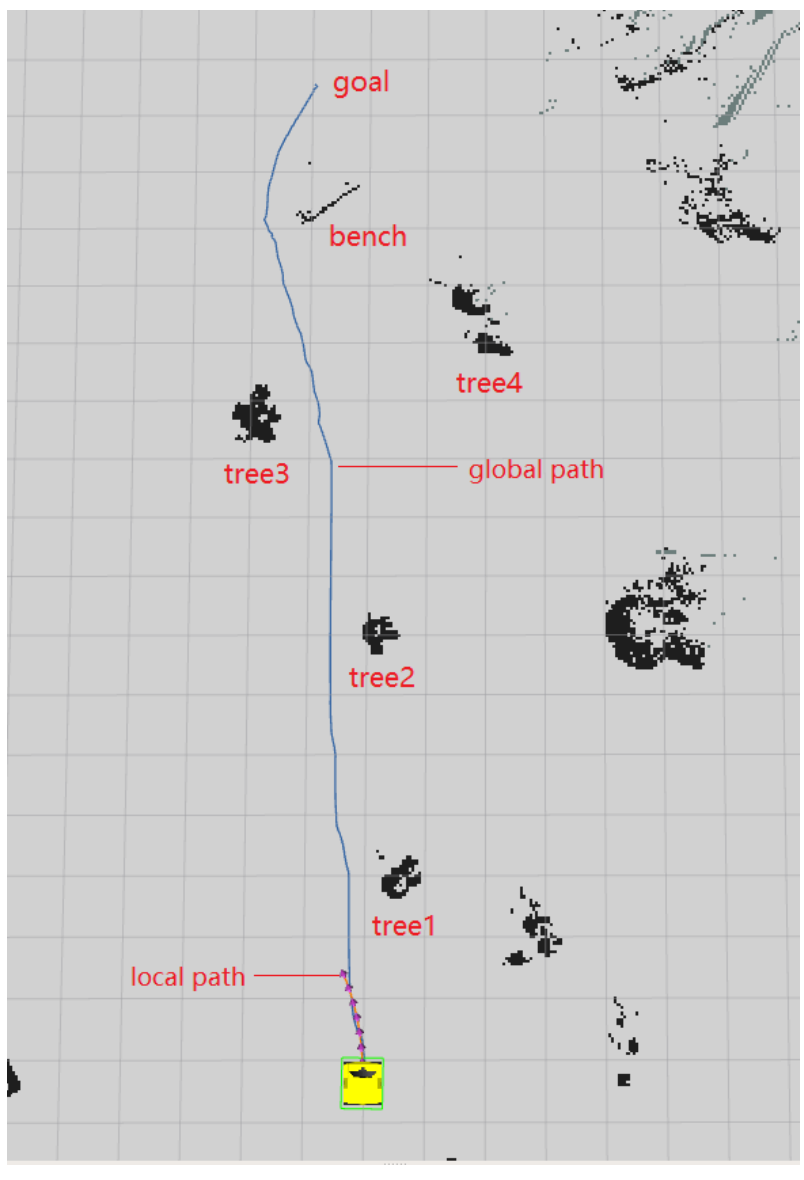
Figure 12. Navigation results.